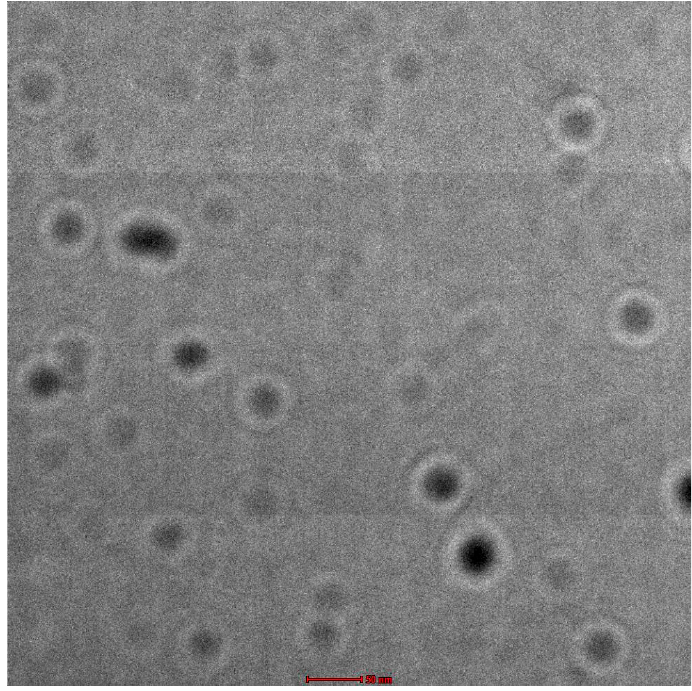
Figure 2. TEM measurement (scale set at 50 nm).